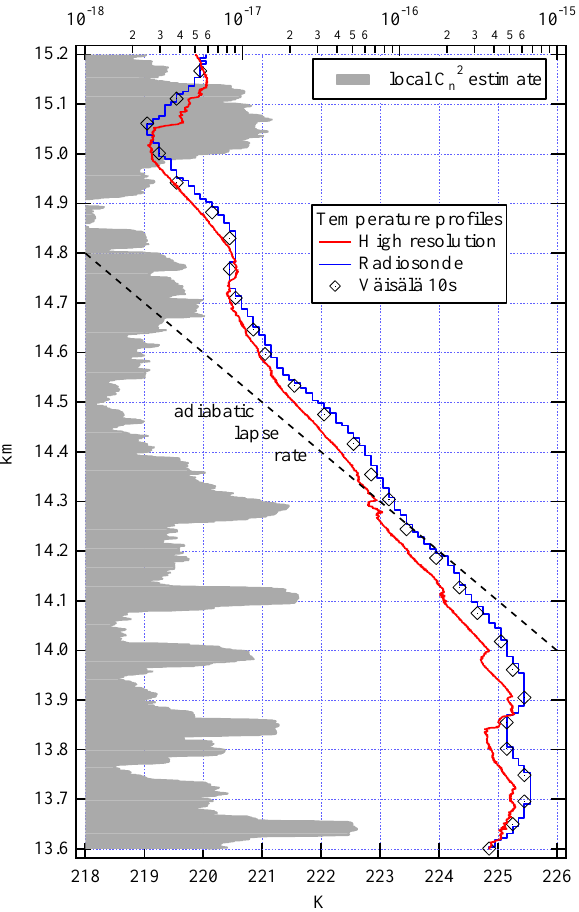
Fig. 6. (a) Dissipation rate of kinetic energy, (cid:15) k , (b) Dissipation rate of available potential energy, (cid:15) p , (c) Ratio (cid:15) p /(cid:15) k , (d) Flux Richard- son